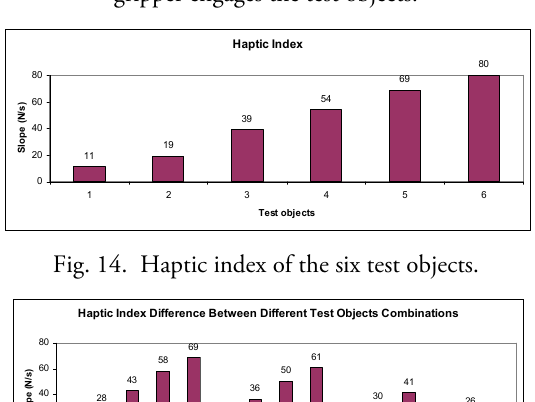
Fig. 13. Feedback force against time graph when the gripper engages the test objects.